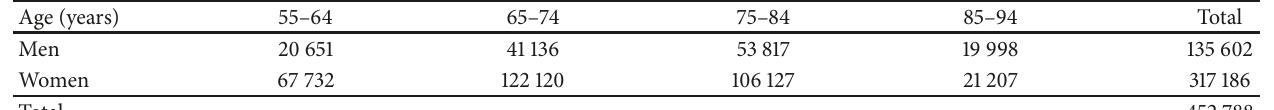
Table 1: Number of widowed men and women. Norway